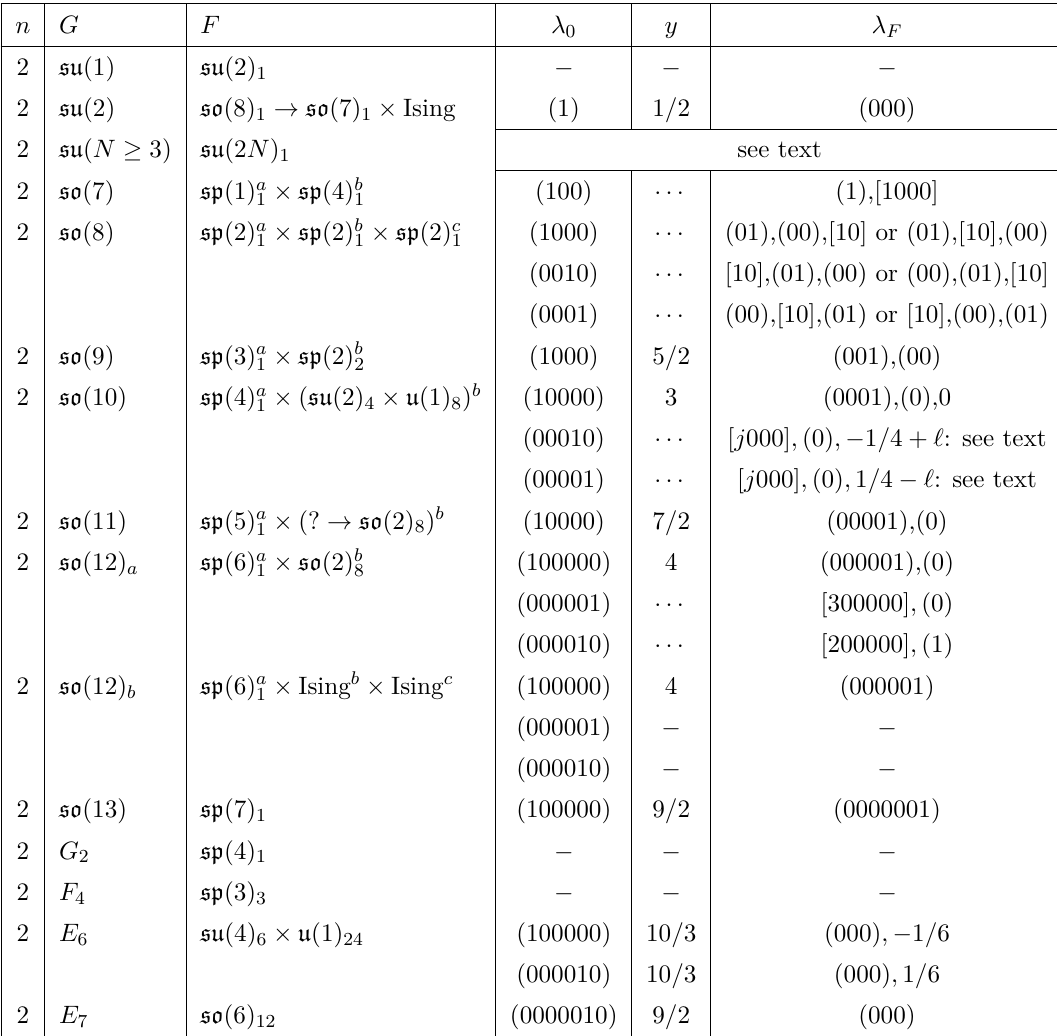
Table 8 . The parameters y, λ F of vanishing blowup equations for rank one models with n = 2 . In the column of λ , the representations are labeled by their highest coweights. When a representation F is composed by many Weyl orbits, we use [ ∗ ] instead of ( ∗ ) to stress the difference. See the main text for more